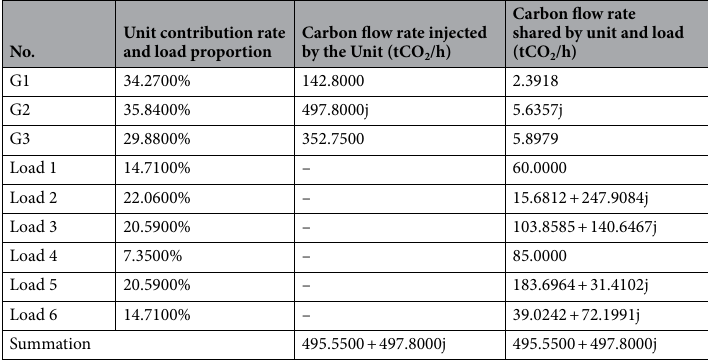
Before the surge